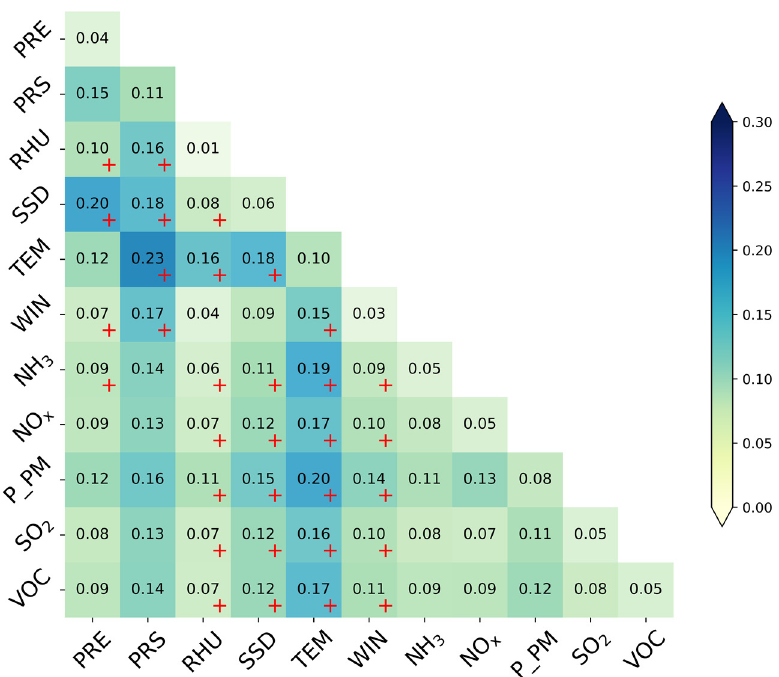
Figure 7. The inter-annual interaction in the factors influences the spatial pattern of PM2.5 concentrations in the Yellow River Basin. Note: “+” means that the type of interaction belongs to nonlinear enhancement; otherwise, it belongs to bivariate enhancement. (PRE denotes accumulated precipitation; PRS denotes surface air pressure; RHU denotes 2-m relative humidity; SSD denotes sunshine duration; TEM denotes air temperature; WIN denotes 10-m wind velocity; NH 3 denotes ammonia; NOx denotes nitrogen oxides; P_PM denotes primary PM2.5; SO 2 denotes sulfur dioxide; VOC denotes volatile organic compounds.)